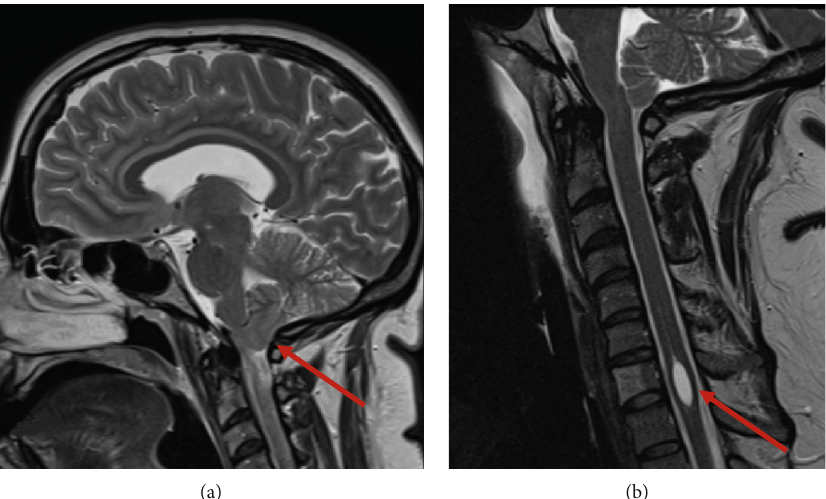
Figure 1: T2-weighted MRI demonstrating Arnold-Chiari I malformation. (a) shows a 7mm downward displacement of the right cerebellar tonsil (red arrow). (b) shows a syrinx centered about C7-T1 measuring 17mm and 5.6mm in the largest longitudinal and axial dimension (red arrow). A benign hemangioma of C7 anterior vertebral body is also identi fi ed.